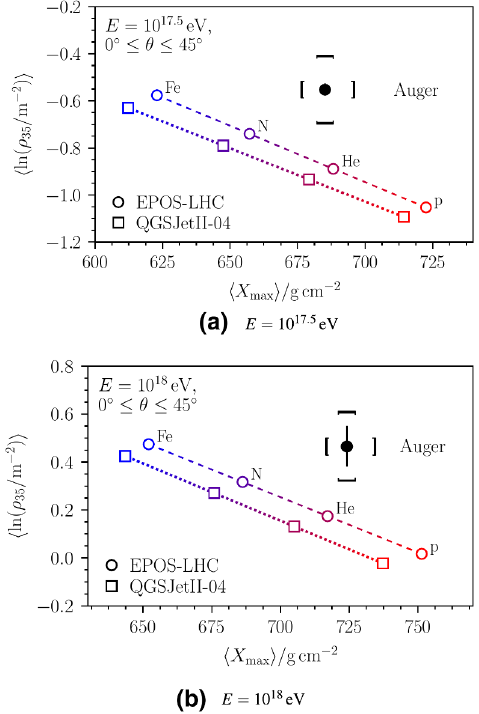
Figure 9. Mean logarithmic muon density < ln ρ 35 > as a func- tion of the mean depth of the shower maximum < X max > for simulations with primary energies of 10 17 . 5 eV (a) and 10 18 eV (b) compared to Auger data.